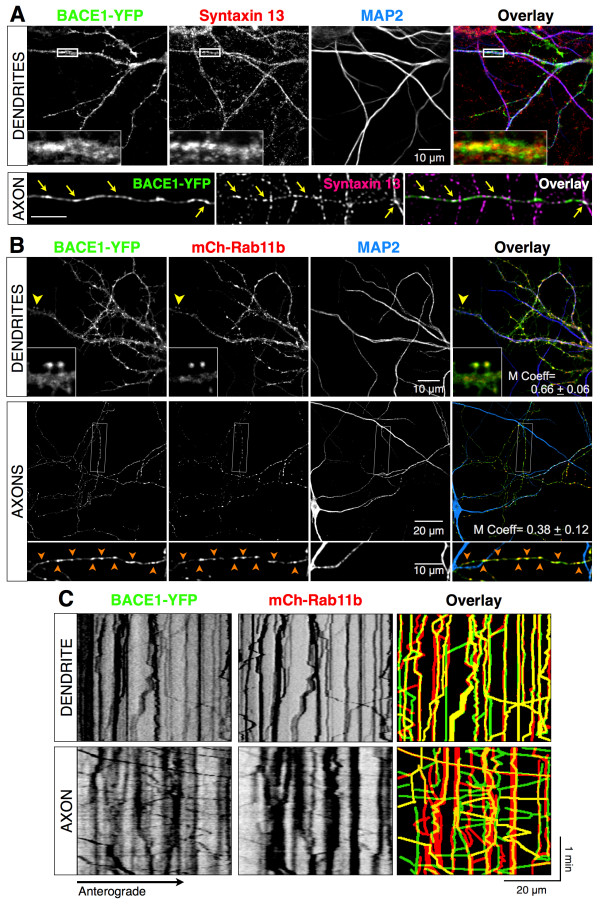
Localization and dynamic transport of BACE1 in recycling endosomes. (A) Colocalization of BACE1 with endogenous syntaxin 13 in dendrites and axons of cultured hippocampal neurons (DIV12). Insets show higher magnification of the boxed area. Images of the dendrites were acquired by confocal microscopy and those of the axon were generated by deconvolution of widefield z-stacks. Dendrites and axons were identified by the presence and absence of MAP2 staining, respectively. (B) Analysis of BACE1 colocalization with Rab11b in dendrites and axons. DIV12 neurons co-transfected with BACE1-YFP and mCherry-Rab11b were immunostained for MAP2. Insets show higher magnification of the area marked by a yellow arrowhead on a dendrite or the boxed area in an axon. Arrowheads indicate vesicles positive for BACE1 and Rab11b along the axon. Manders’ coefficient of colocalization (M Coeff) is indicated (n = 7 neurons). (C) Visualization of BACE1-YFP and mCherry-Rab11b dynamic co-transport by dual-color live cell imaging. Time-lapse images were acquired using the Dual-View two-channel simultaneous-imaging system at the rate of 1 frame/sec for 3 min (Additional file 4). Kymograph analysis reveals bidirectional transport of BACE1 in Rab11b-positive endosomes (yellow tracks in the overlay panels) in both dendrites and axons.